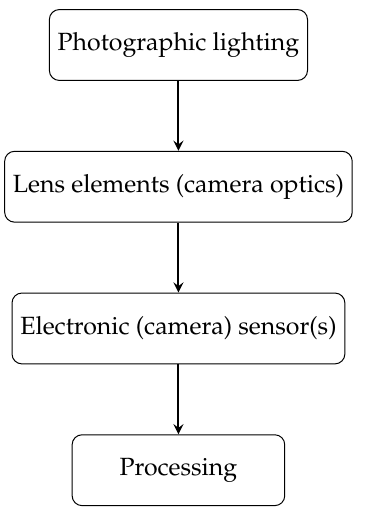
Figure 4. Distortion model based on how the luminous flux reflected from the scene eventually becomes a digital